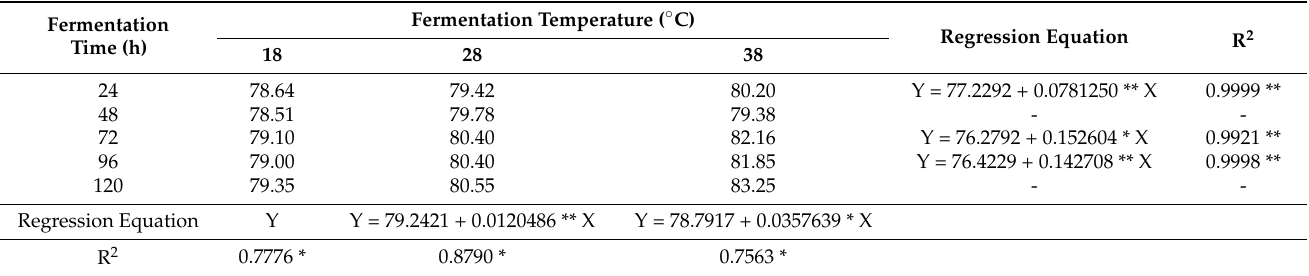
Table 1. Regression models of the total score characteristic as a function of temperature and fermen- tation time and respective coefficients of determination R2. Regression models—* and ** Significant at 5% and 1% probability levels by the t and F tests, respectively.